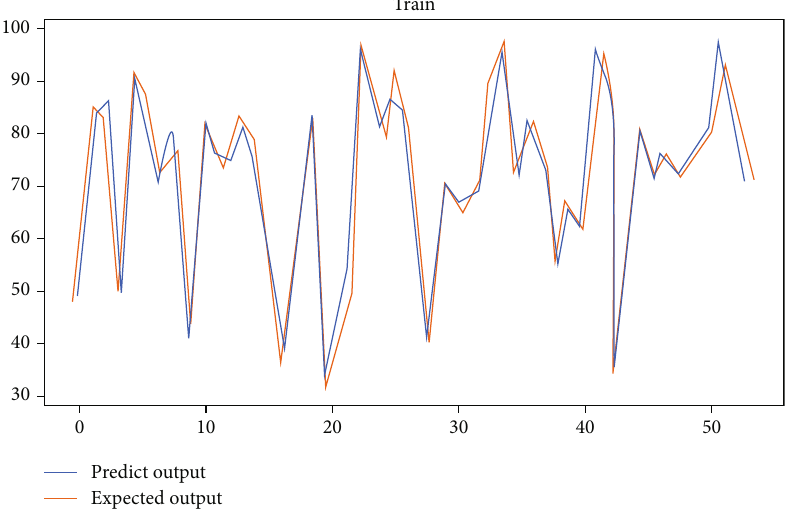
Figure 10: Comparison of training results with the ground